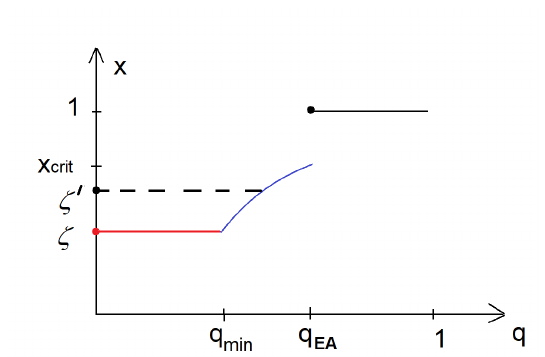
Figure 8: Here the derivative of the function − T χ ( C ) : the curved part is essentially independent of the temperature, while the plateau to the left is given by ζ . The transition takes place when the line x = ζ intersects the curved part effective temperature for the system): at this point the relaxation takes place with only two possible values for x ( q ) (see Fig. 8). At the transition point one should observe in Fig. 7 two straight lines with slope − ζ and − 1, that intersect with each other at the point C = q